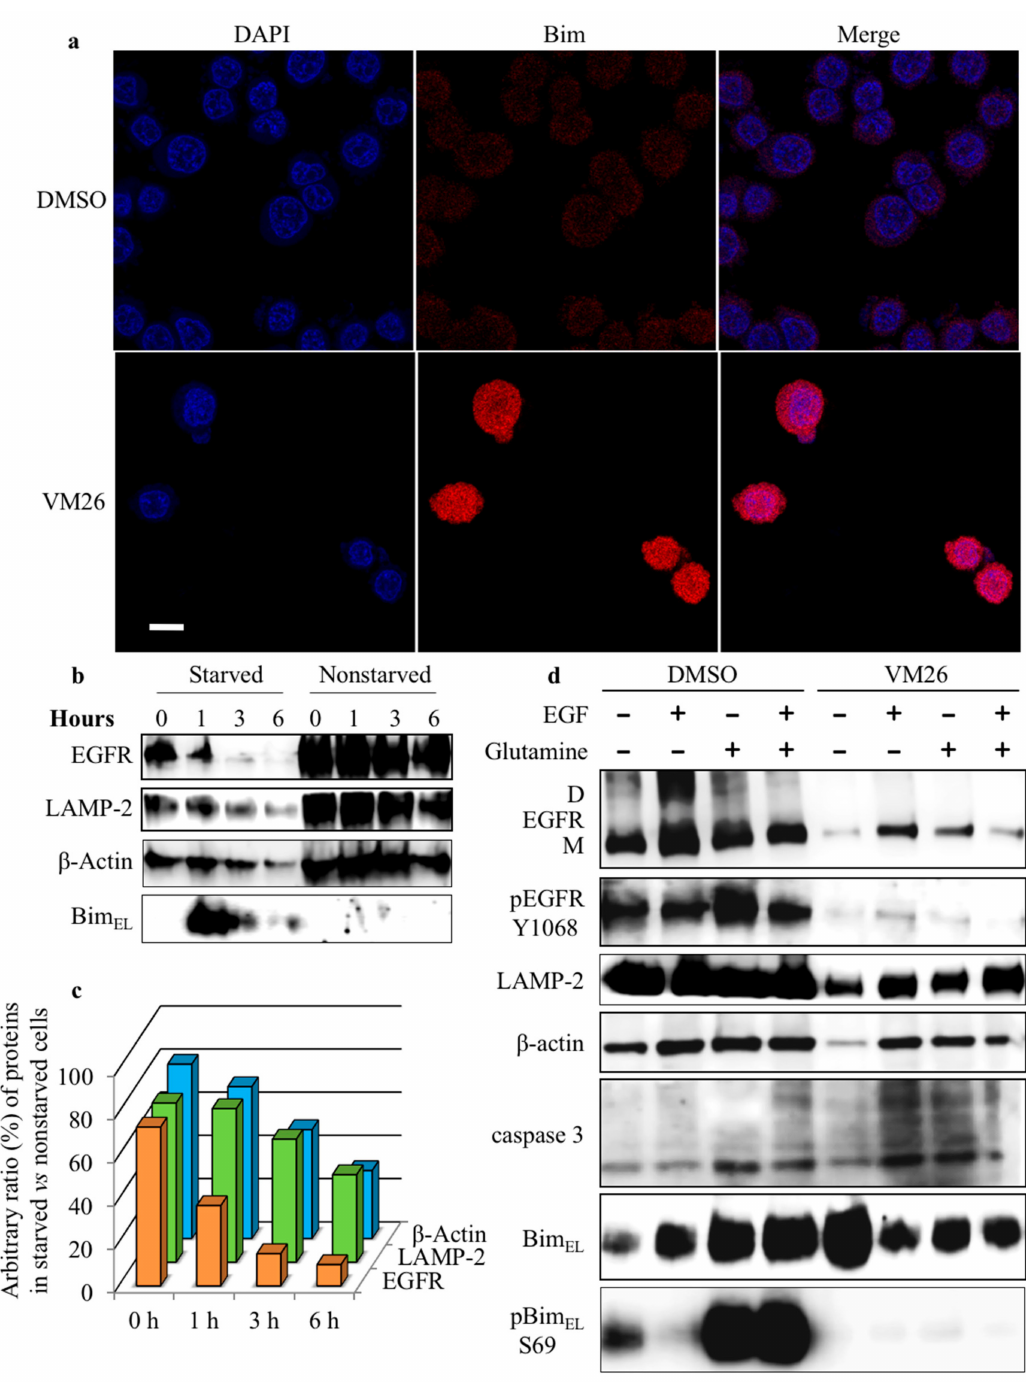
Figure 6. The compound VM26 promotes sequestration of Bim in MDA-MB-468 cells. ( a ) Bim response to the compound VM26. Treatment conditions were similar to Figure 3c; the immunofluorescent detection was carried out in permeabilized cells with anti-Bim mAb. ( b ) Kinetics of protein expression in the cells treated with 25 µ M VM26. ( c ) Relative levels of proteins were estimated as their ratio in starved cells to nonstarved cells considering 100% of each protein in nonstarved cells. ( d ) Impact of the addition of EGF (200 ng / mL) and glutamine (2.0 mM) on protein profiling in cells left untreated or treated simultaneously with 25 µ M VM26 for 6 h in FBS-deprived medium. Proteins were extracted in moderate-strength lysis bu ff er. The EGFR monomer (M) and dimer (D) are